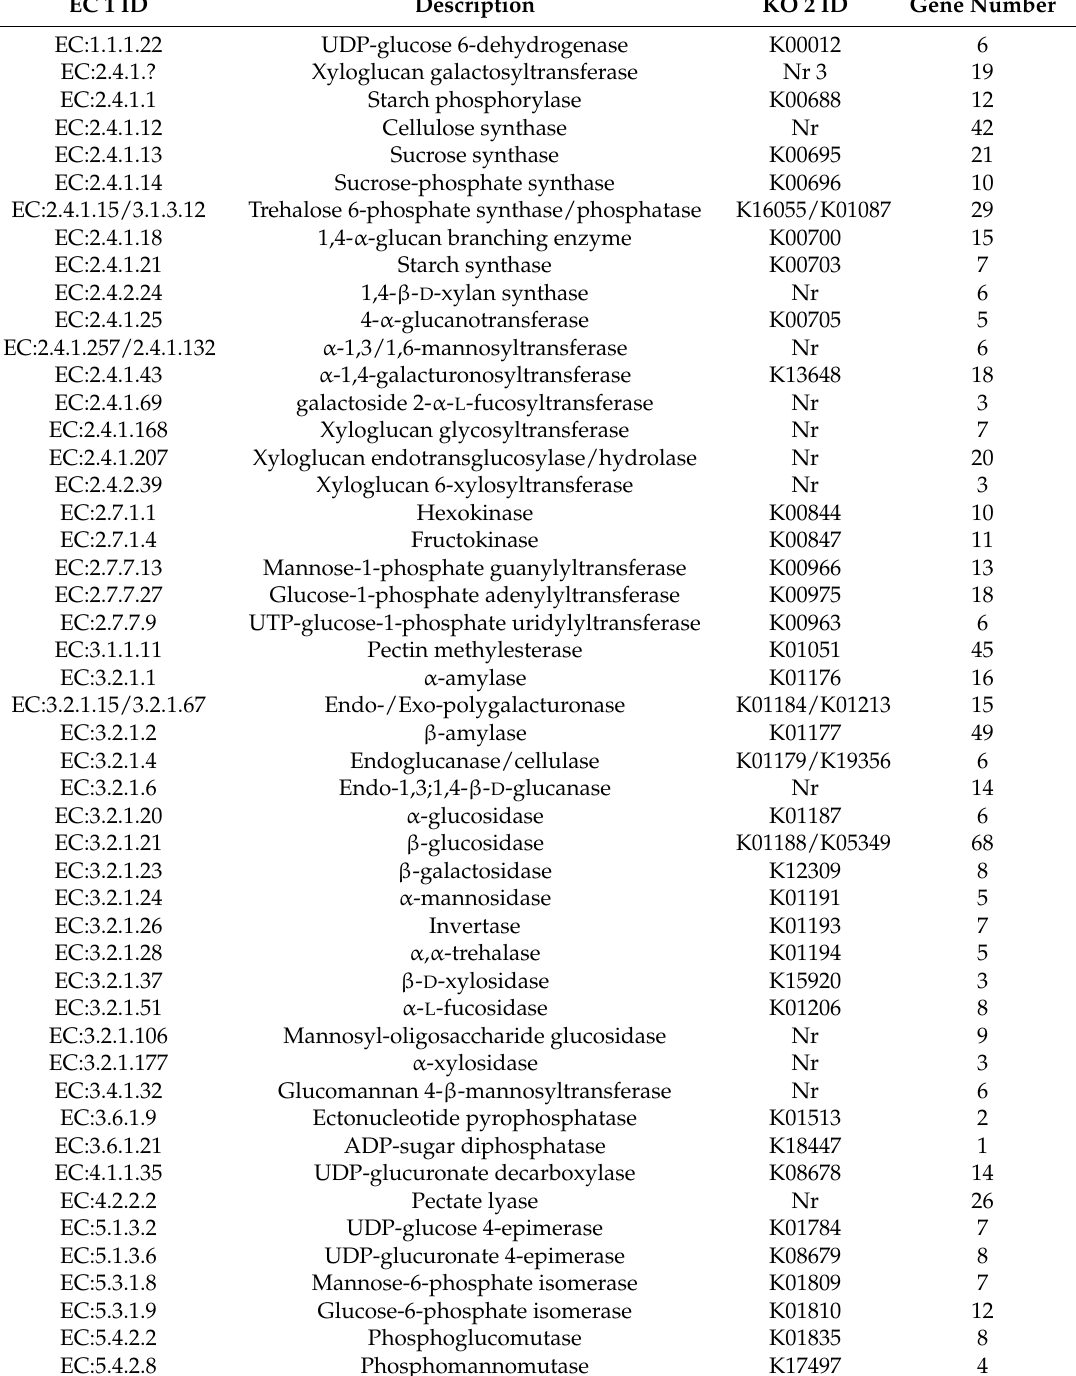
Table 3. Statistics of genes involved in starch and sucrose metabolism (ko00500) pathway. EC 1